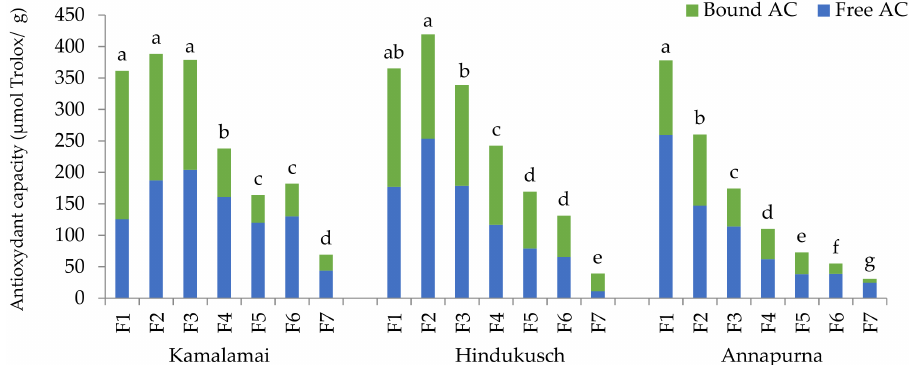
Figure 5. Antioxidant capacity ( µ mol Trolox/g) detected in seven pearling fractions in three food barley genotypes. Results are presented as the mean; different letters indicate significant differences between pearled fractions of each genotype on log-transformed data; (Tukey-Kramer’s HSD for α =